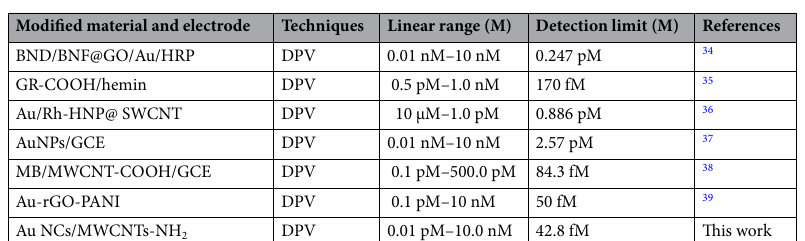
Table 1. Comparison of linear ranges and detection limits of the different RNA biosensors.